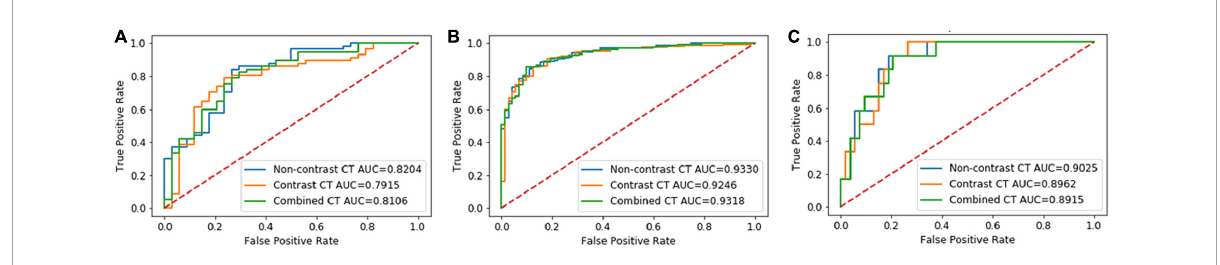
FIGURE3 Results of the receiver-operating characteristic (ROC) curve analysis. The ROC curves of the NCCT, CECT, and combined models for identification of invasive adenocarcinoma (IAC) in solid nodule group (A) , partly solid nodule group (B) , and pure ground glass nodule group (C) are